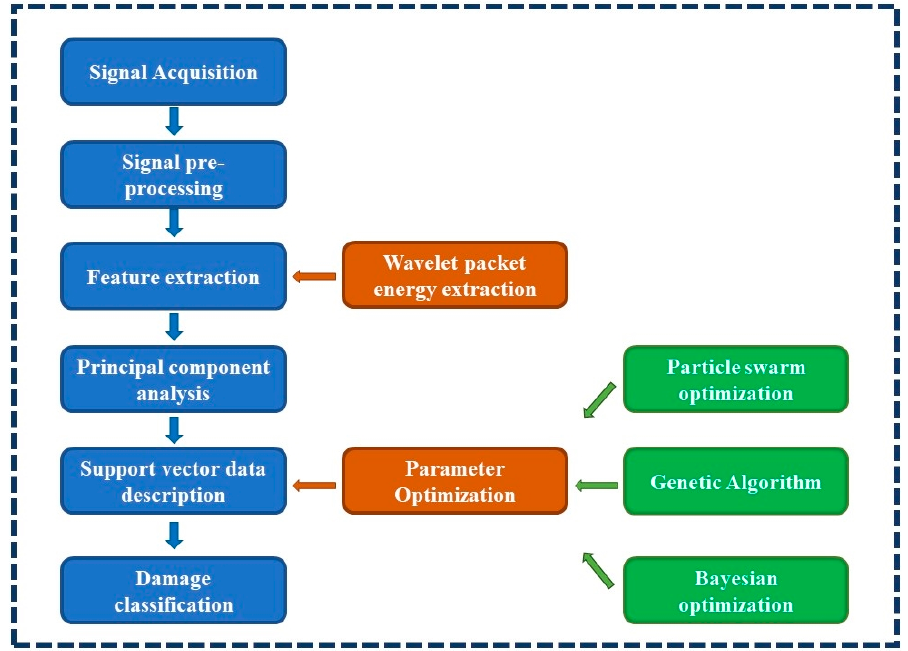
Figure 1. Flowchart of the method.